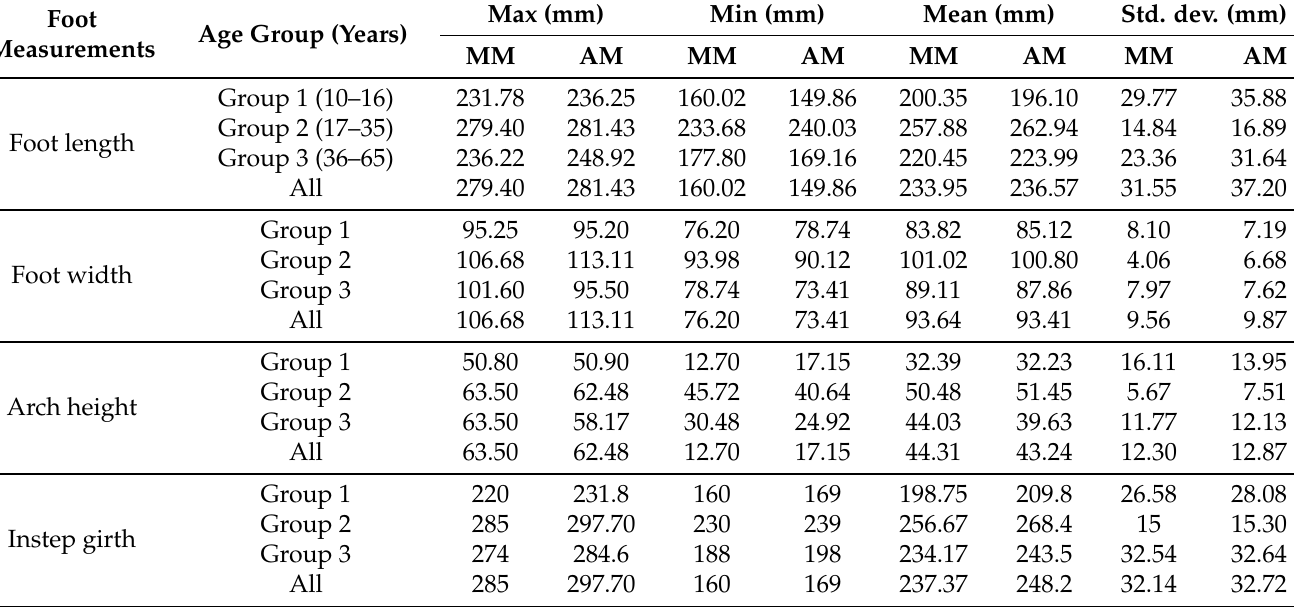
Table 2. Descriptive statistics of all measurements obtained from the two methods, MM and AM. All measurements are in millimetres